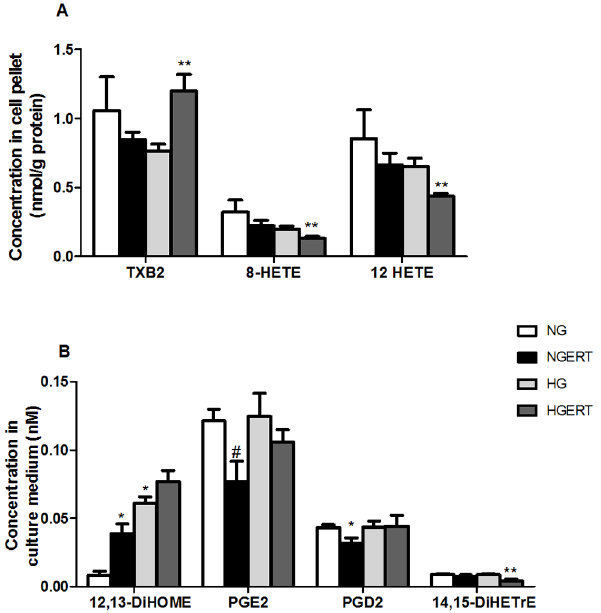
Figure 4. Effect on eicosanoid concentrations. Effect of pre/co incubation with 5 mM erythritol (ERT) on HUVECS cultured in normal glucose (NG, 7 mM) or high glucose (HG, 30 mM) for 24 hours on eicosanoid concentrations in cell pellets (A) and culture medium (B). Data are expressed as means 6 standard error of three independent experiments. *=p , 0.05 compared to NG; **=p , 0.05 compared to HG; # =p , 0.1 compared to HG.